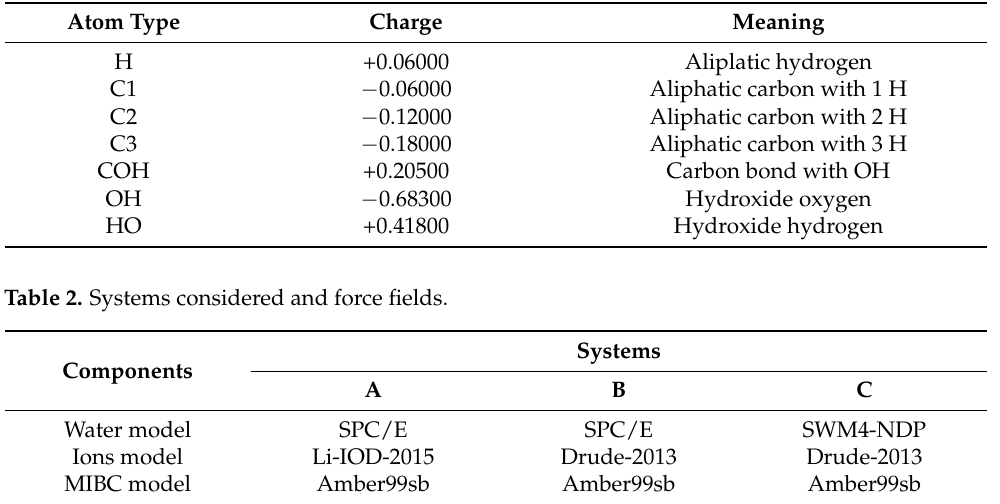
Table 1. Partial charges for MIBC molecules.